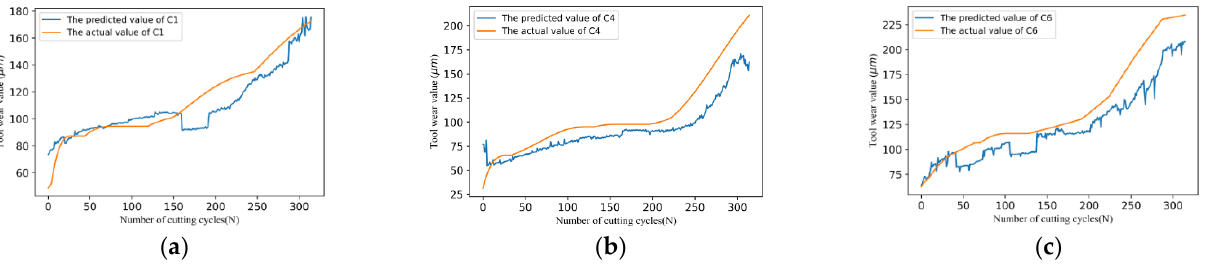
Figure 11. Prediction results of MSCNN+CBAM model on datasets. ( a ) C1, ( b ) C4, and ( c ) C6. P MAE = 11.53, P MSE = 223.01. Table 2. Experimental processing parameters table. Table 3. Experimental results of adding white Gaussian noise to cutting force signals.